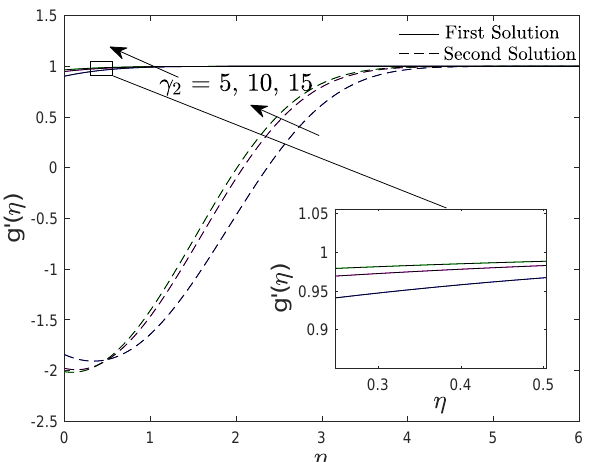
Figure 3. Nanofluid velocity along the y -direction for diverse values of γ 2 with λ = − 1,1.